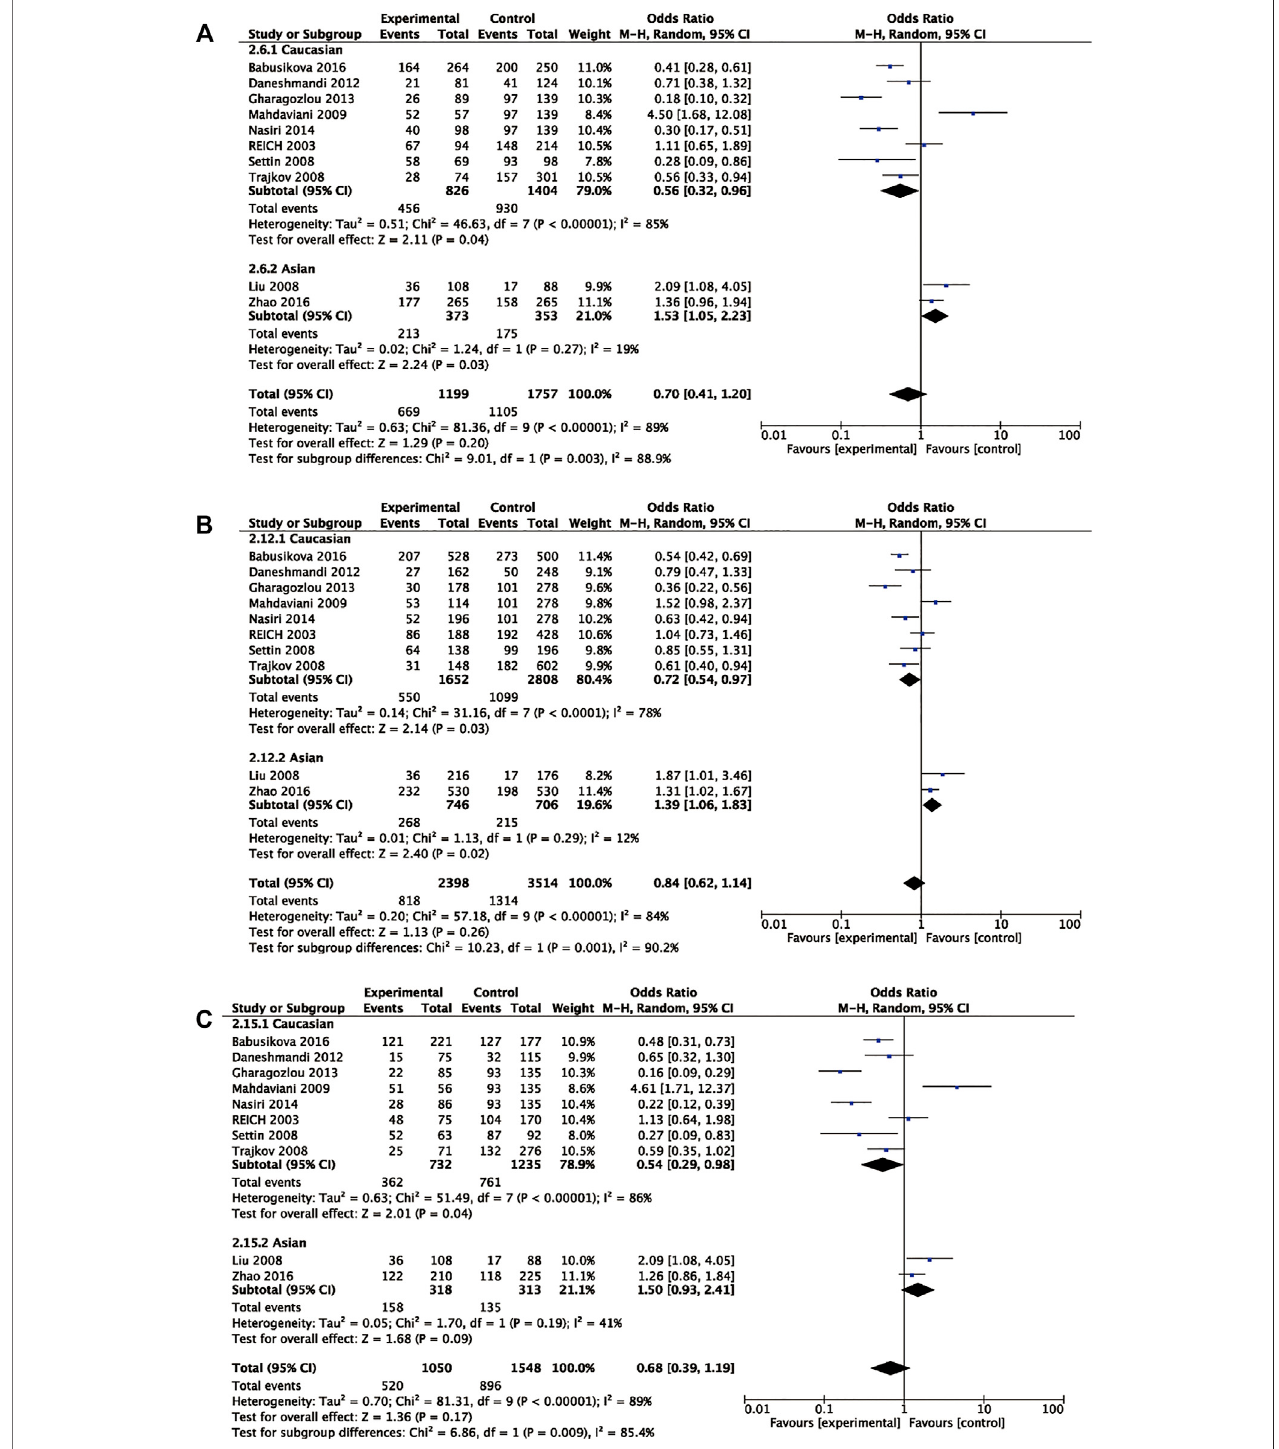
FIGURE 2| Pooled OR and 95% CIof individual studies and pooled data for the associationbetween IL6 rs1800795and allergic diseases risk in different ethnicity subgroups for (A) dominant comparison, (B) allele comparison, and (C) heterozygote comparison.